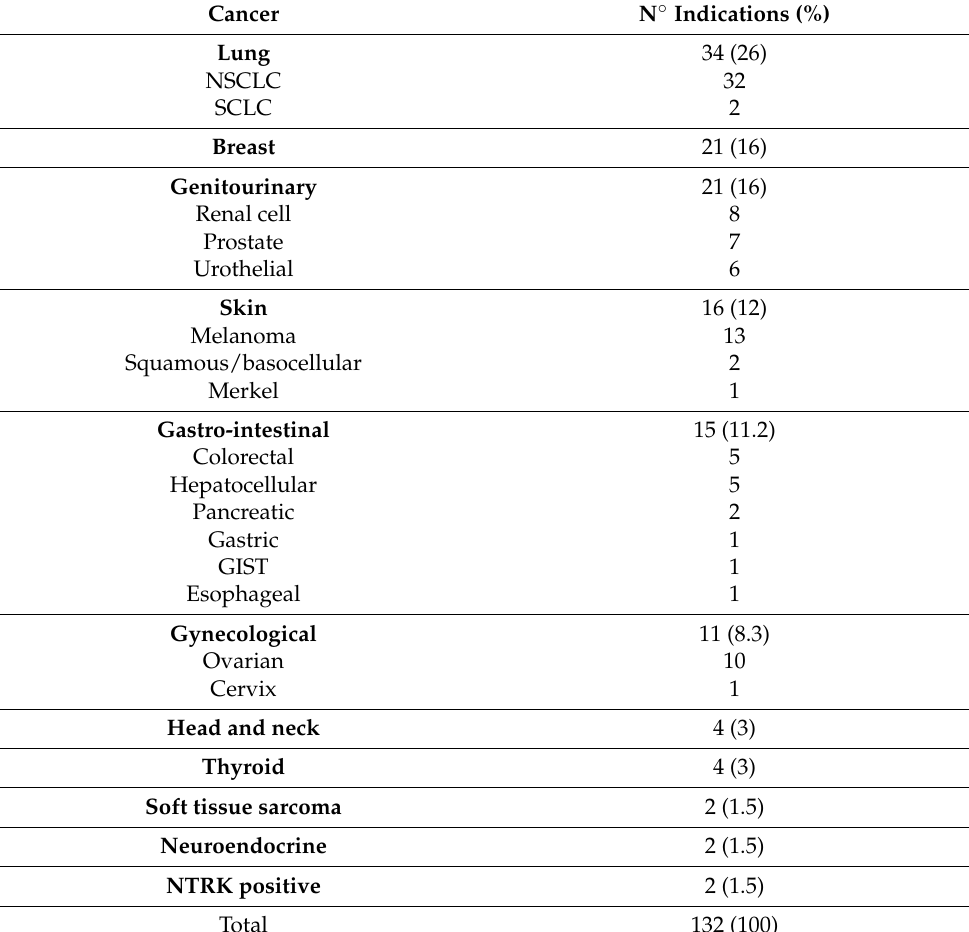
Table 2. Indications for solid